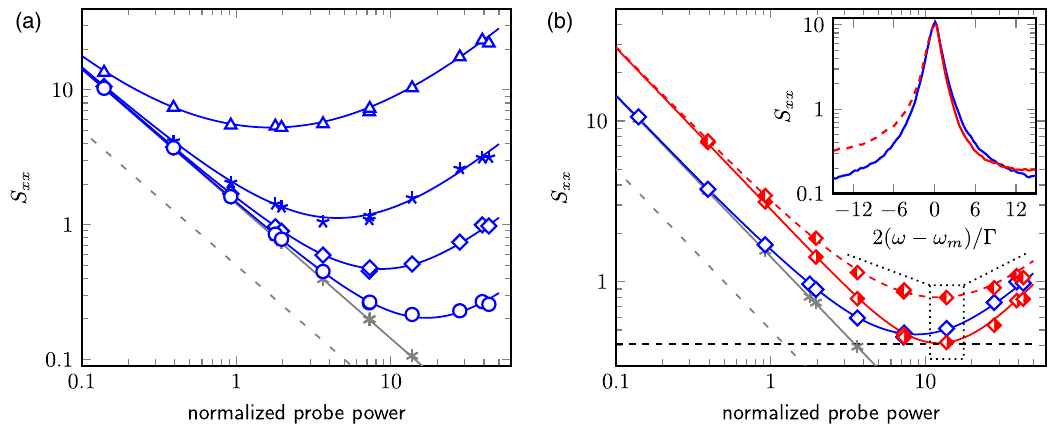
FIG. 2. Measured displacement PSD for different frequencies and measurement angles as a function of normalized probe power p . = Γ ¼ 0 (triangles), 2.5 (stars), 5 (squares), 10 (circles). (b) Measurement (a) Measurement at ϕ ¼ 90 ° at different frequencies: 2 ð ω − ω m Þ at ϕ ¼ 90 ° (blue) and at ϕ ¼ 45 ° (red) compared to SN level at ϕ ¼ 90 ° quadrature (gray). Measurement at ϕ ¼ 45 ° at frequency 2 ð ω − ω = Γ ¼ − 5 (square filled on left, dashed red line) results in larger imprecision, and at frequency 2 ð ω − ω = Γ ¼ 5 (square m Þ m Þ = Γ ¼ 5 evaluated at quantum filled on right, solid red line) results in reduced imprecision. The dashed black line is the QL for 2 ð ω − ω m Þ 1 . 29 . Red and blue lines are full power-dependent expectation for efficiency ϵ ¼ 0 . 35 , plus thermal contribution due to n th ¼ = Γ , at ϕ ¼ 90 ° (blue) and ϕ ¼ 45 ° (red) corresponding data points. Inset: Measured PSD as a function of frequency 2 ð ω − ω m Þ quadratures for power p ¼ 14 , as indicated by the dotted box in main figure. For this choice of ϕ , negative detunings (red dashed) yield worse sensitivity, while positive detunings (solid red) are improved. In both (a) and (b), the gray asterisks are SN measurement at ϕ ¼ 90 ° for ϵ ¼ 0 . 35 , and the dashed gray line is for ϵ ¼ 1